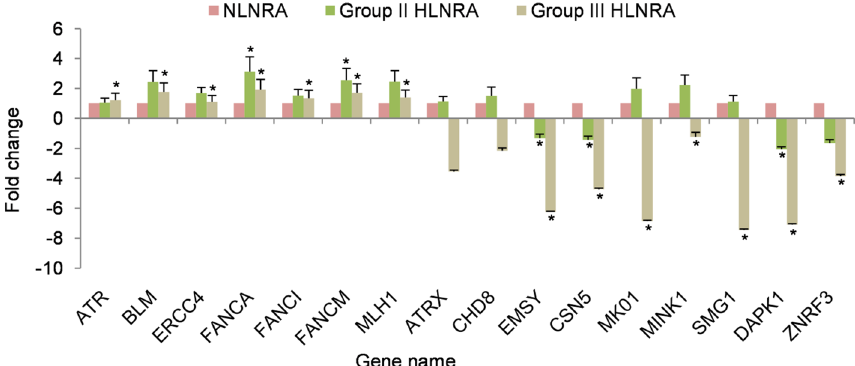
Figure 6. Real time qPCR analysis for 16 candidate proteins identified with iTRAQ. The bars correspond to relative fold change values represented as mean ± SEM (n = 3). Symbol (*) represents statistical significance calculated by Student’s t-test ( P ≤ 0.05) in individuals from HLNRA dose groups (N = 5), relative to individuals from NLNRA dose group (N =